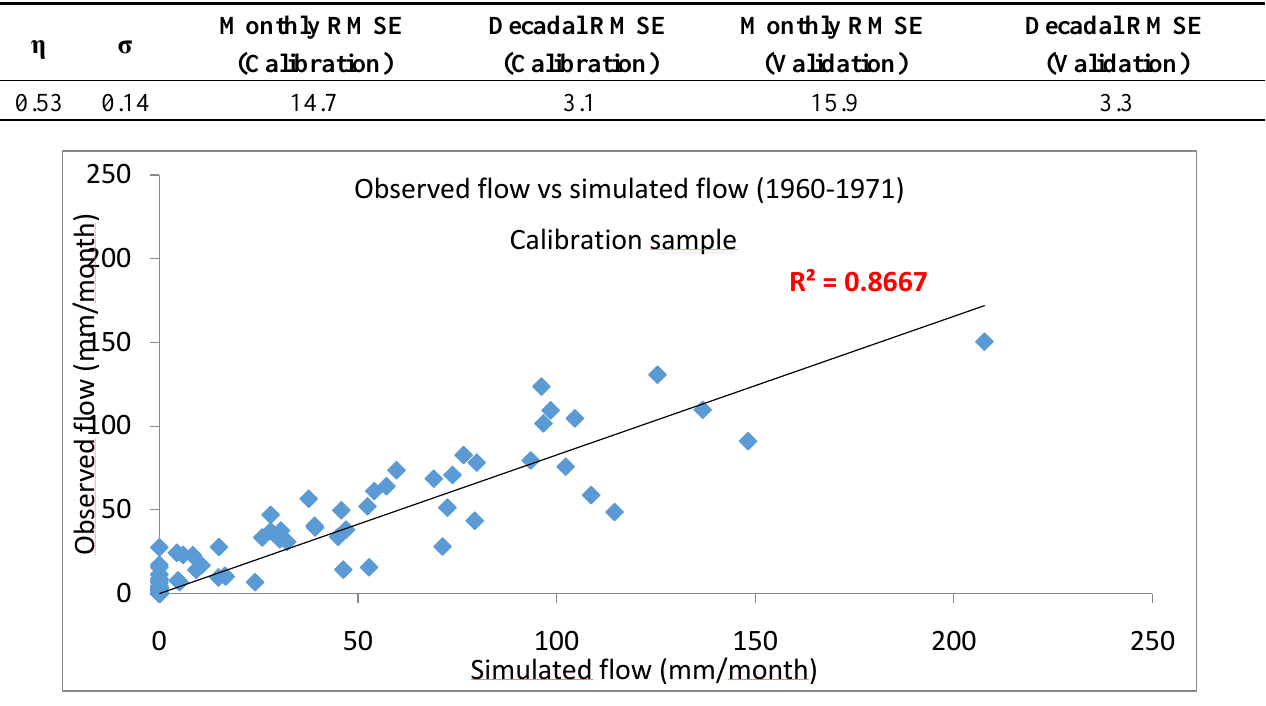
Table 1. Model parameters and quality criteria.